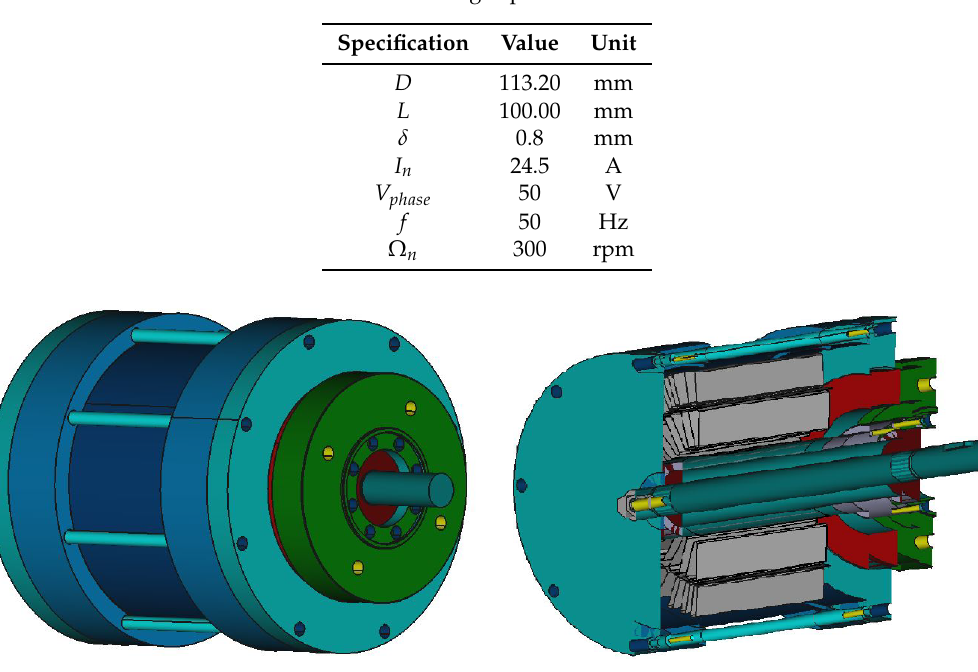
Figure 11. Three dimensional sectioned rendering of the Self Excited Synchronous Machine